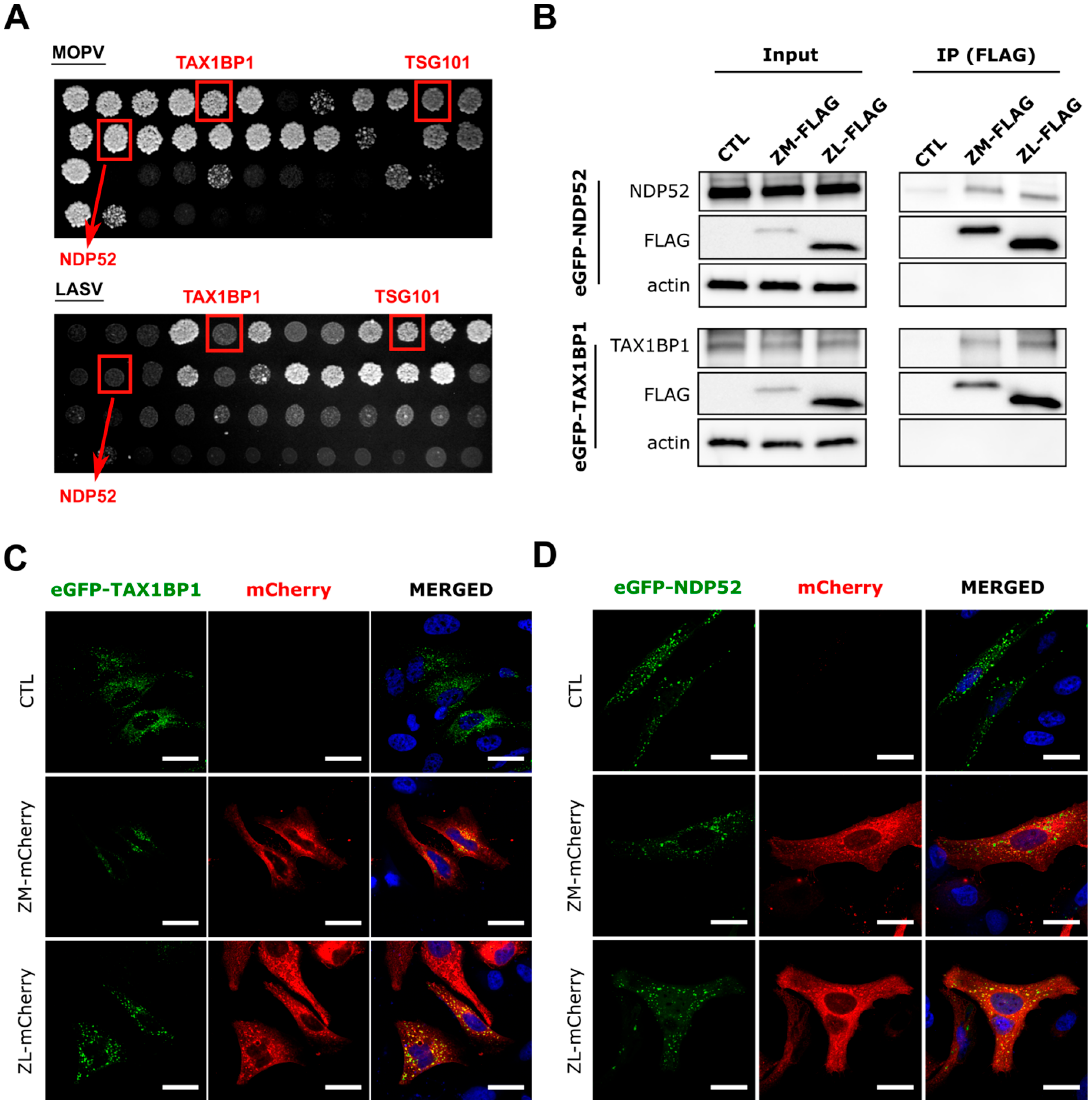
Figure 1. Confirmation of the interaction between MOPV and LASV Z protein and the host cell proteins NDP52 and TAX1BP1. ( A ) images of plates with “gap-repair colonies” (performed in duplicate). Clones were plated onto selective media (-L-W-H + 3AT) and left to grow for two weeks; ( B ) extracts from 293T cells cotransfected with the indicated expressing plasmids for 15 h were immunoprecipitated (IP) with FLAG magnetic beads. Exogenous eGFP-NDP52 and eGFP-TAX1BP1 were detected by Western blotting ( n = 3 independent experiments). ( C , D ) HeLa cells were cotransfected with the indicated plasmids for 15 h and fixed for confocal microscopy. Exogenous eGFP-NDP52 and eGFP-TAX1BP1 are shown in green and the Z-mCherry viral proteins in red ( n = 3 independent experiments). All images were taken on a confocal Zeiss LSM 510 with an Axioscope 63× oil immersion lens objective. Scale bar represents 30 µm. Table 1. Selected “autophagy-linked” host protein interactors of LASV and MOPV Z identified by Y2H and validated by gap-repair. The first and second columns correspond to the canonical gene names and gene IDs, respectively, for the selected interacting cellular proteins. Columns 3 and 4 provide a summarized role of the corresponding protein in autophagy pathways and the reference, respectively. Column 5 shows the number of positive yeast colonies obtained for each cellular protein for the indicated virus Z protein (retrieved from mouse brain, human spleen cDNA libraries and ORFeome). Column 6 shows the results obtained for the validation step by gap-repair in yeast. The “x” indicates the presence of growing colonies for the selected condition. Tsg101 has already been described by others and served as a positive control.